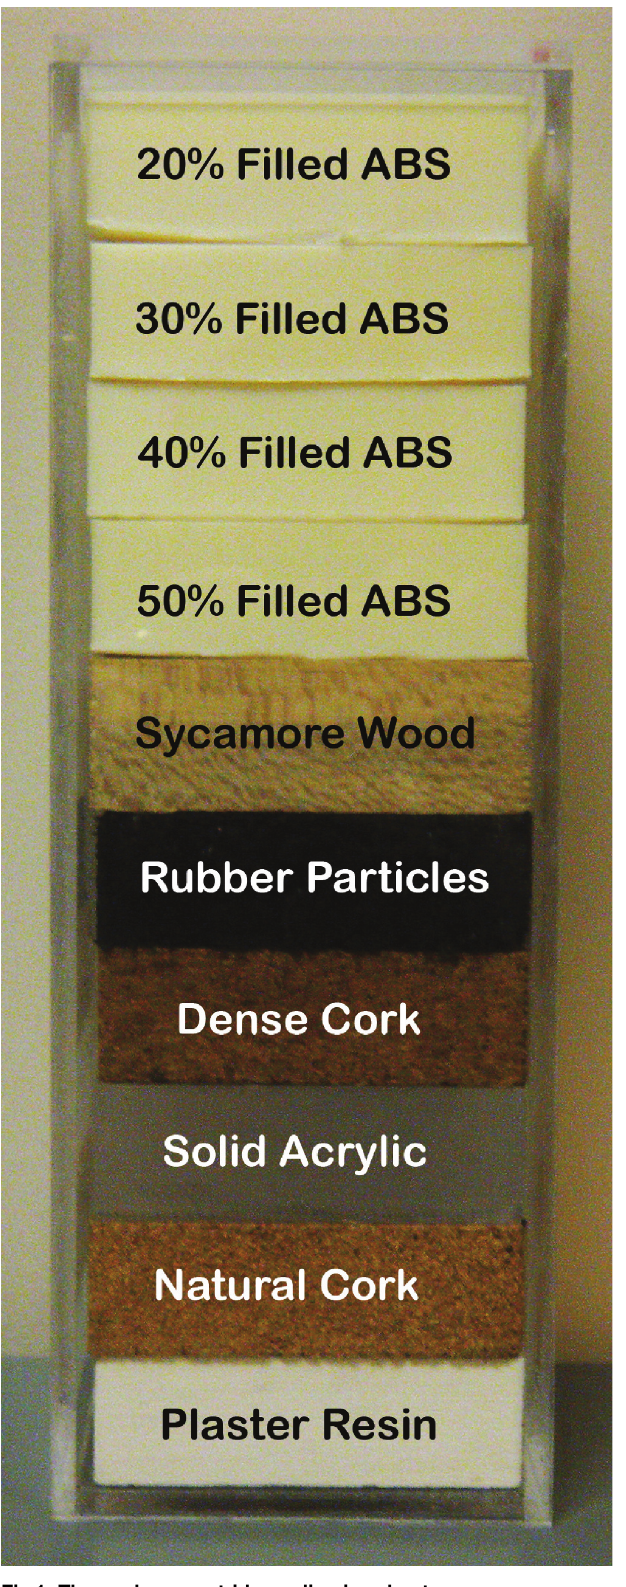
Fig 1. The credencecartridge radiomics phantom. https://doi.org/10.1371/journal.pone.0178524.g001 PLOS ONE | https://doi.org/10.1371/journal.pone.0178524 September 21,